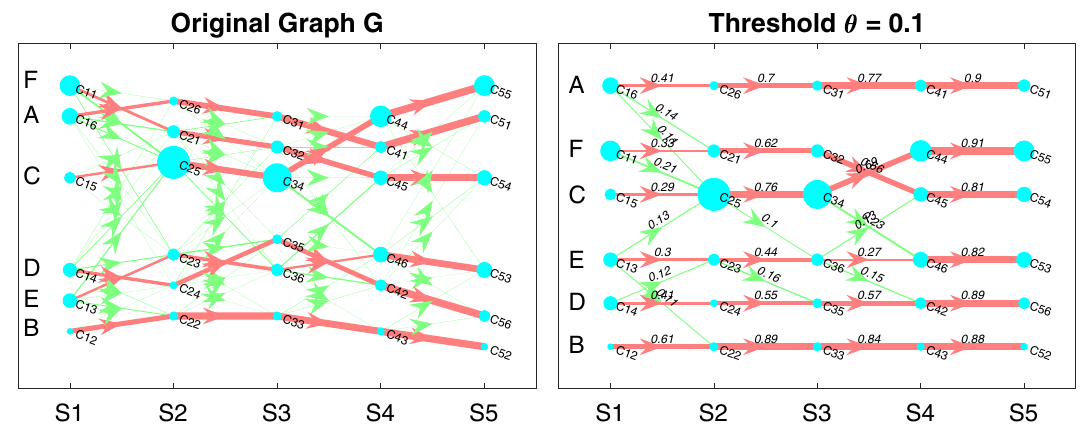
Fig. 18 The evolution graph G for Snapshot 1–5. The size of each node denotes the number of patients inside this node. An edge rep- resents the relationship between two clusters with the weight as the